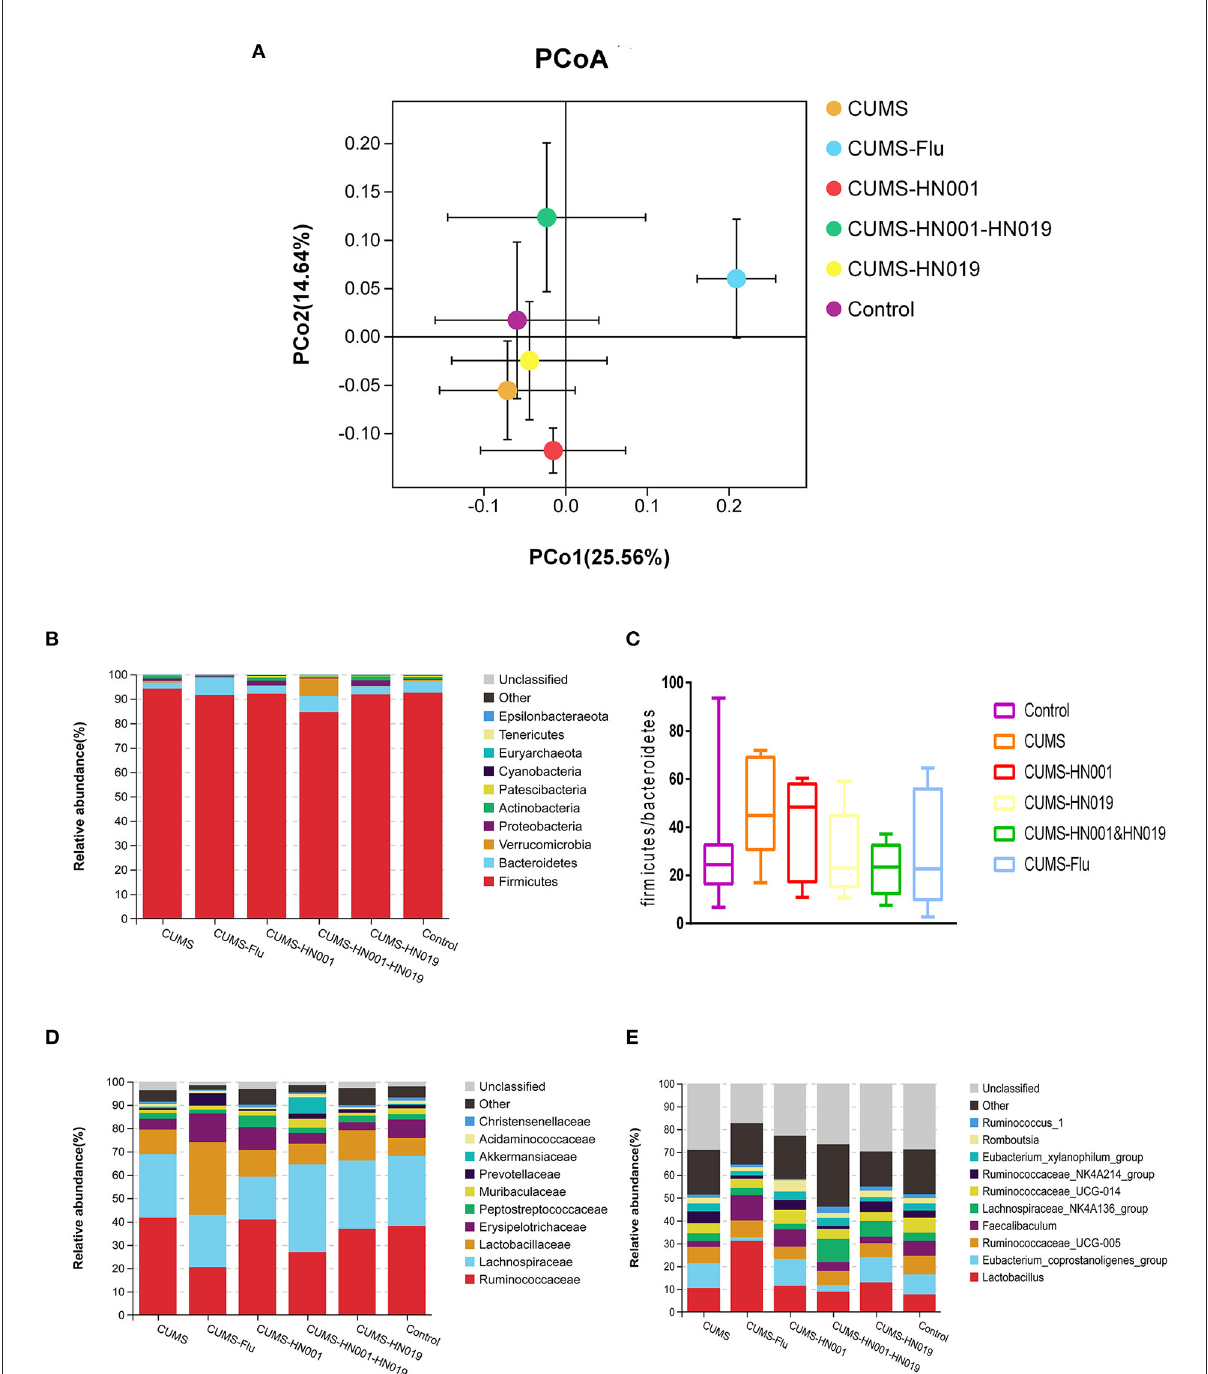
FIGURE8 Analysis of microbiota flora composition among six groups. (A) unweighted PcoA, (B,D,E) difference of microbiota flora abundance at the phylum, family and genus among six groups. The area of each color represents the abundance of different bacteria in the intestine. The larger the area, the higher the abundance, and vice versa. Data are stated as mean percentage values from each group ( n = 7). (C) Comparison of the ratio of Firmicutes to Bacteroidetes among six